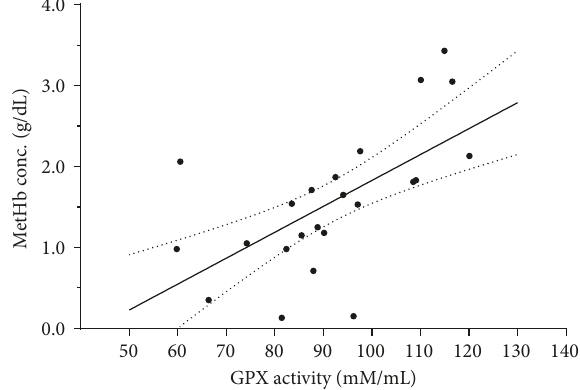
Figure 3: Correlation analysis of serum GPX activity and serum MetHb to total hemoglobin ratio among heroin-addicted subjects. A significant direct and linear association was evident with r � 0.777, p � 0 . 001. The continuous line defines the best fit linear correlation model while the dotted lines define the standard error means